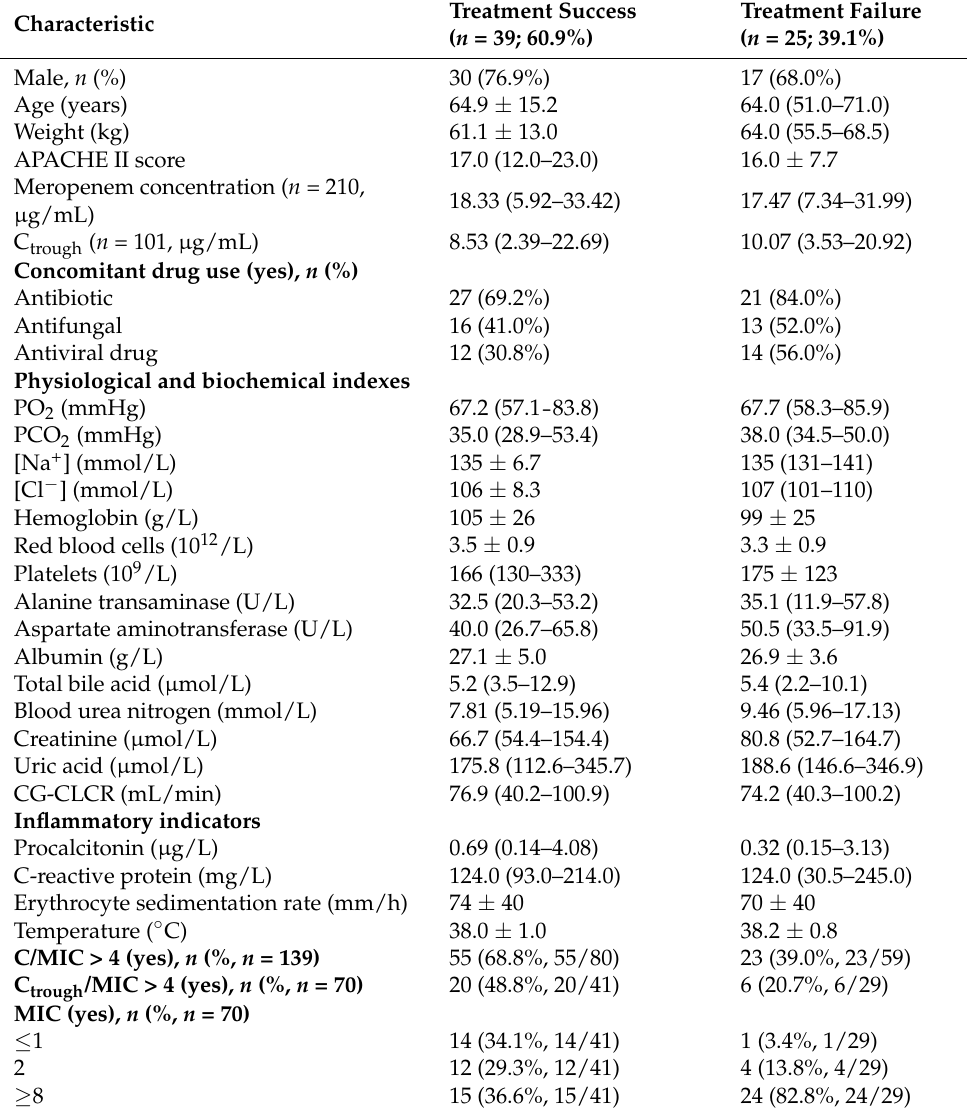
Table 1. Clinical characteristics of the two treatment